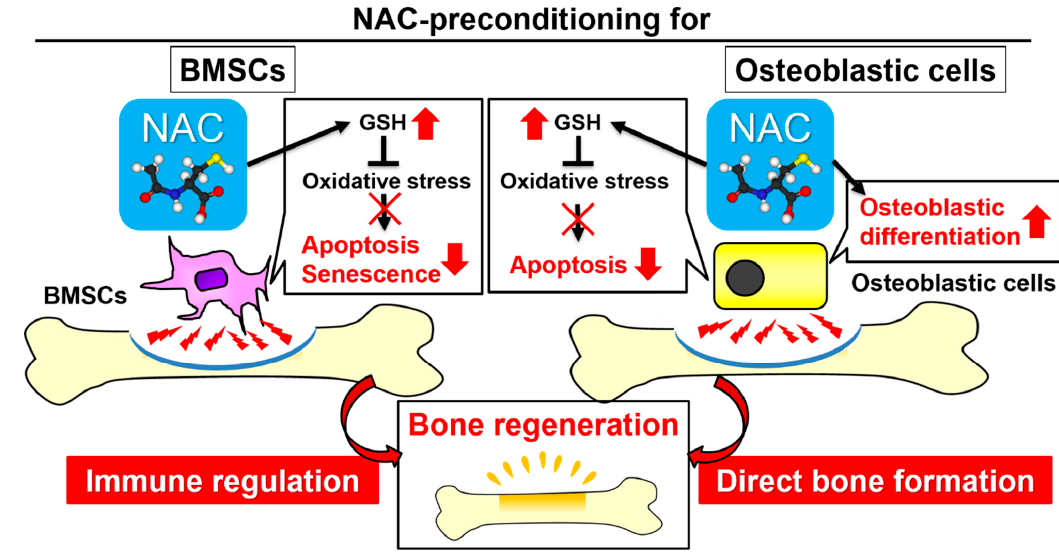
Figure 9. Scheme illustrating the proposed mechanism underlying the enhancement of bone regeneration by preincubation of bone marrow stromal cells (BMSCs) and osteoblast-like cells with N -acetyl- L -cysteine (NAC) for autologous local transplantation, respectively. As in BMSCs and osteoblast-like cells, uptake of NAC prevents oxidative stress-mediated apoptosis and / or cellular senescence by increasing the level of the primary antioxidant molecule, glutathione. BMSCs or osteoblast-like cells preconditioned with NAC can survive during acute inflammation in the recipient site. Surviving BMSCs are indirectly involved in bone formation through regulatory functions for the immune system, whereas surviving osteoblast-like cells are directly involved in bone deposition through enhancement of bone-forming ability with upregulated osteogenic di ff erentiation. Pathways in BMSCs are based on our previous study